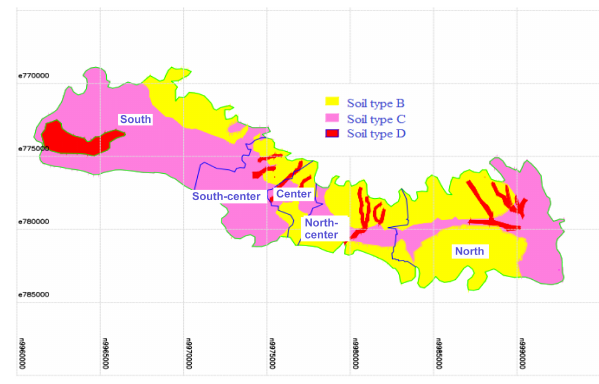
Figure 4. Soil classification in